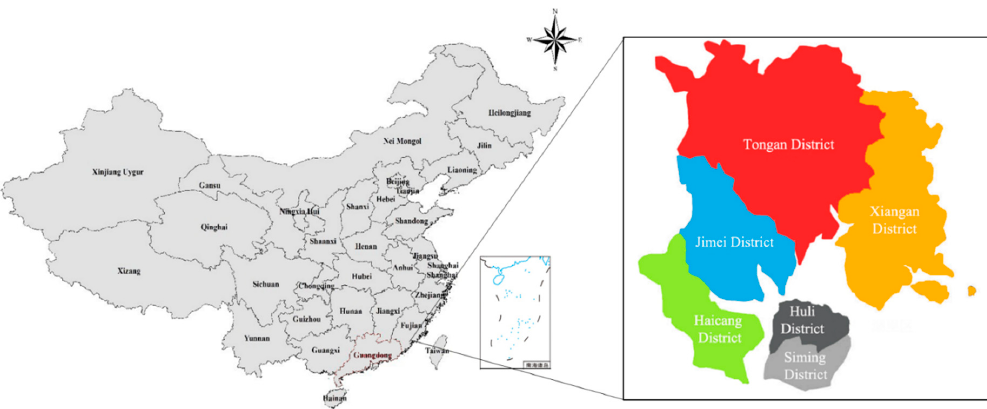
Figure 1. The administrative division map of Xiamen